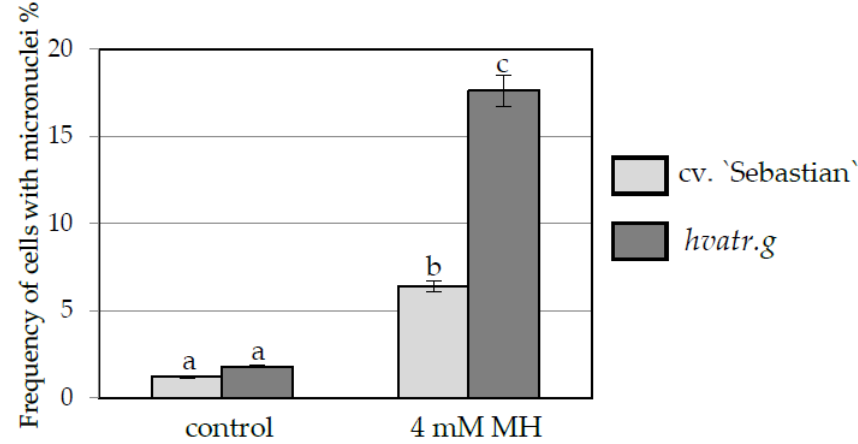
Figure 4. Frequency of cells with micronuclei in root of barley seedlings of the hvatr.g mutant and cv. “Sebastian”, control and MH-treated. Error bars represent the standard deviations of the mean. Statistical analyses were performed using ANOVA ( p < 0.05) followed by Tukey’s honestly significant difference test (Tukey HSD test, p < 0.05). Statistically significant differences are indicated by different letters.